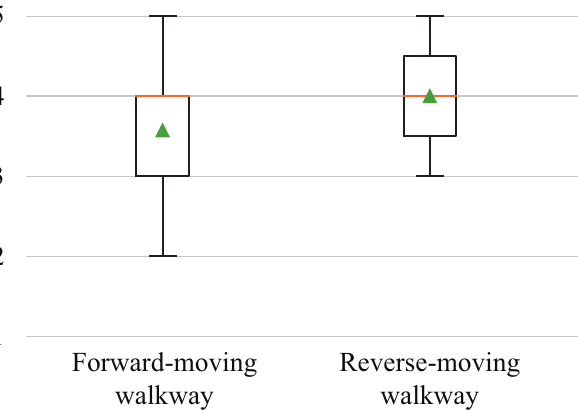
Figure 19. Results of the question, “I felt I walked faster/slower than without the AR texture.” We hypothesized that displaying the moving walkway as an AR texture would change the participants’ walking speed, but there was no difference at a short distance of eight meters as in this case. On the other hand, the participants felt that their walking speed increased or decreased when the moving walkway texture was